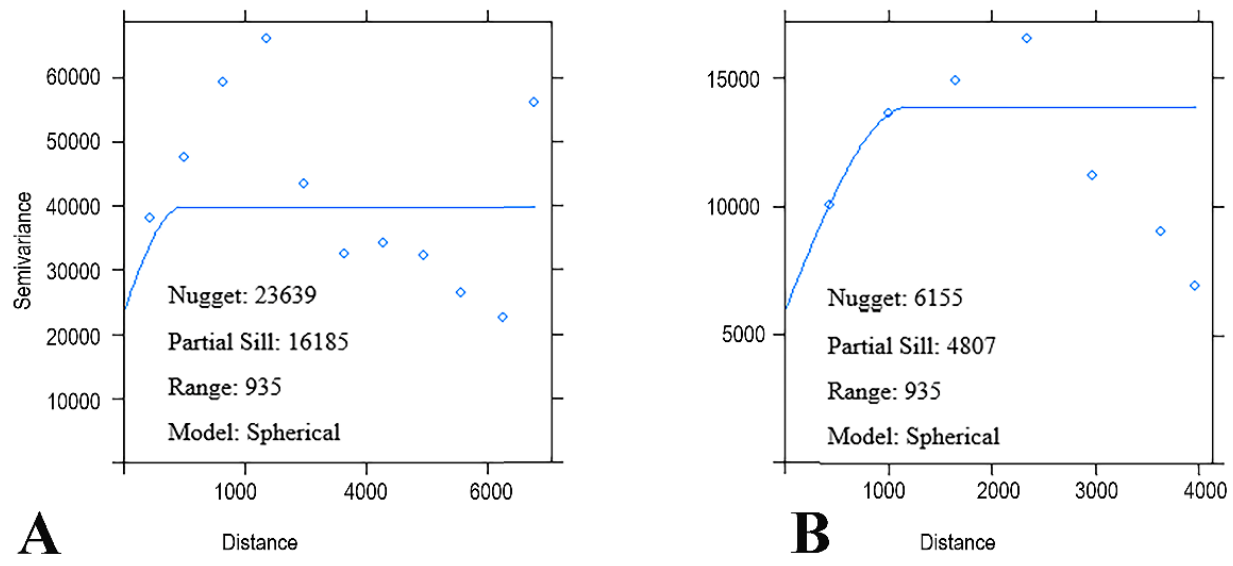
Figure 2. Strength of the spatial autocorrelation among evaluated model residuals for EC. SVR: support vector regression ( A ), RF: random forest ( B ).